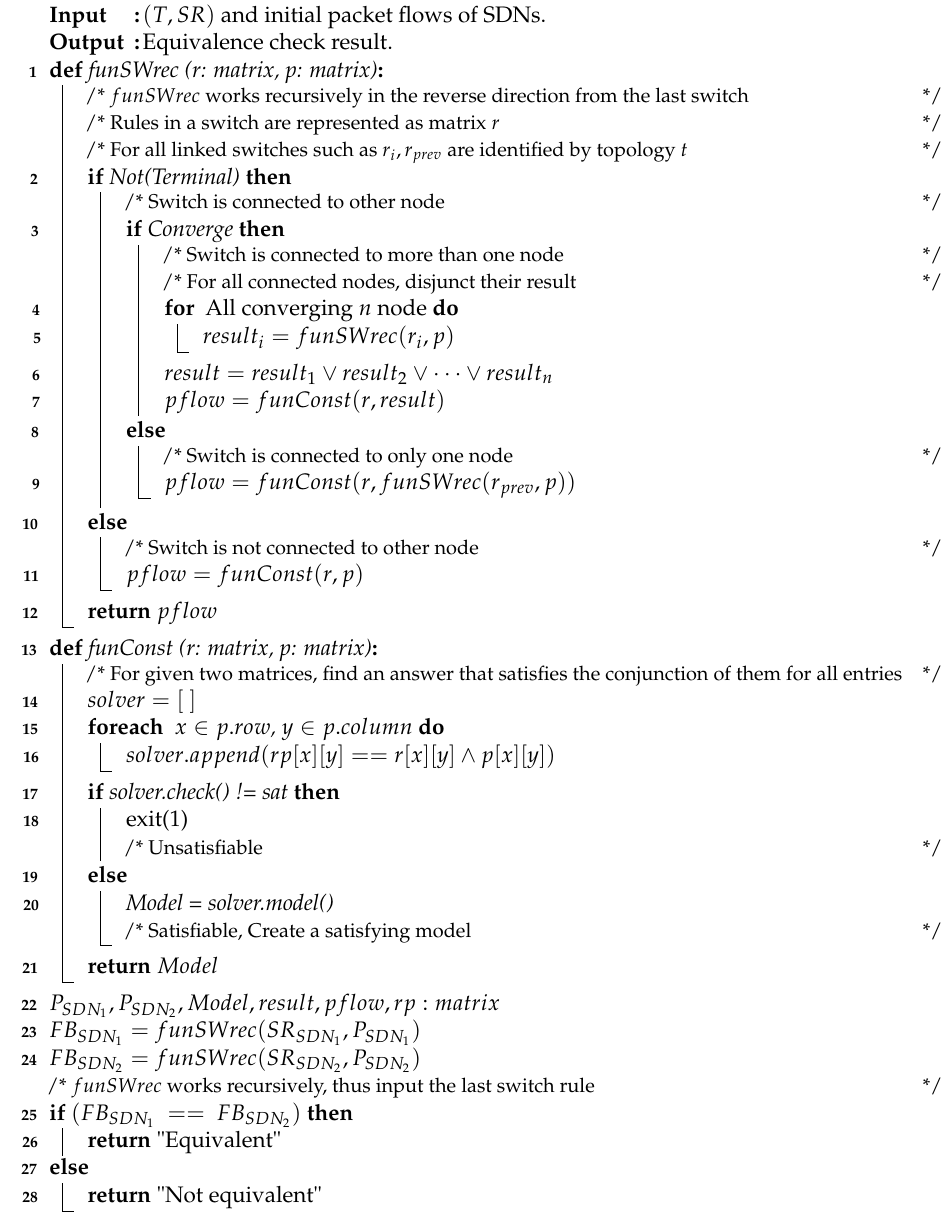
Algorithm 2: SDN equivalence check